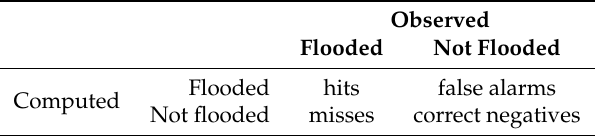
Table 6. Contingency table used to calculate the Critical Success Index.